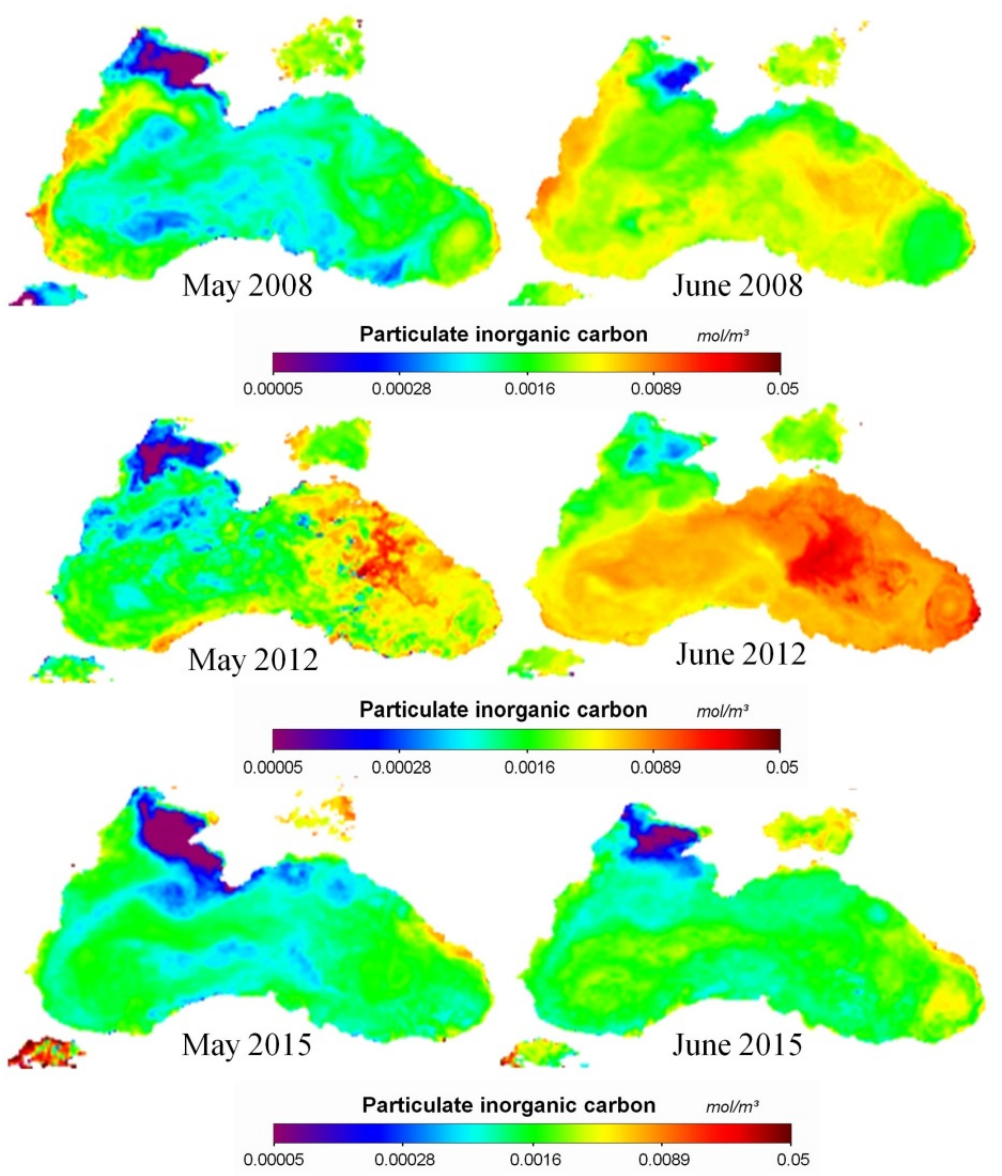
Figure 14. Development of coccolithophore blooms (PIC average monthly values) in the zone of the Batumi anticyclone in May and June 2008, 2012, 2015, according to the MODIS-Aqua data.